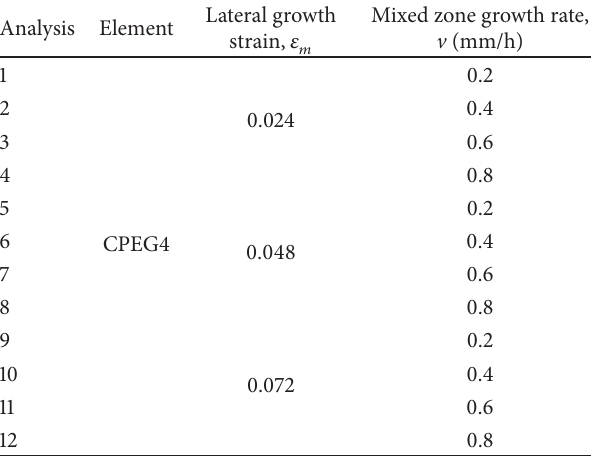
Table 2: Research protocols used in this paper. Analysis Element